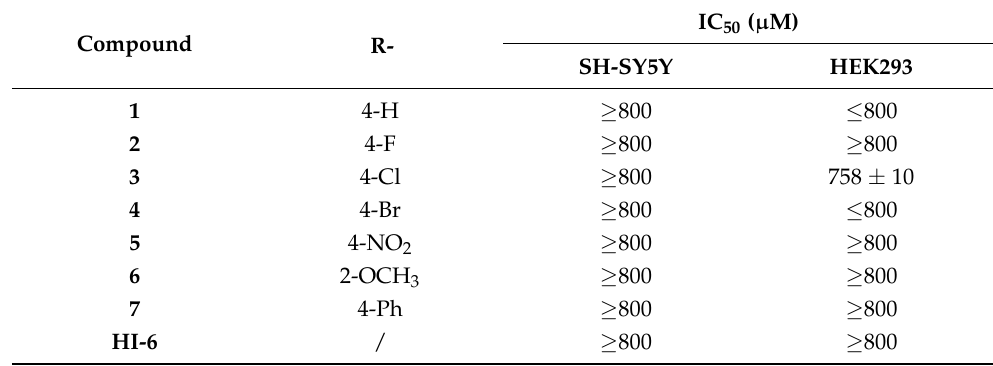
Table 5. Cytotoxicity of the tested compounds on the SH-SY5Y and HEK293 cell lines expressed as IC 50 values ( µ M). The experimental data is presented as the mean of at least three experiments.